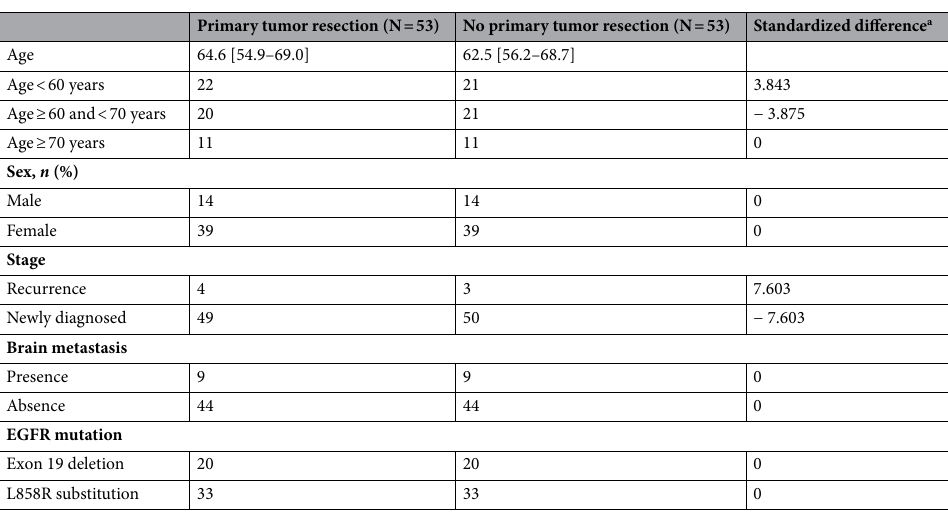
Table 1. Demographic and clinical characteristics of all patients. EGFR epidermal growth factor receptor P. a Standardized difference (%) is the mean difference divided by the pooled standard